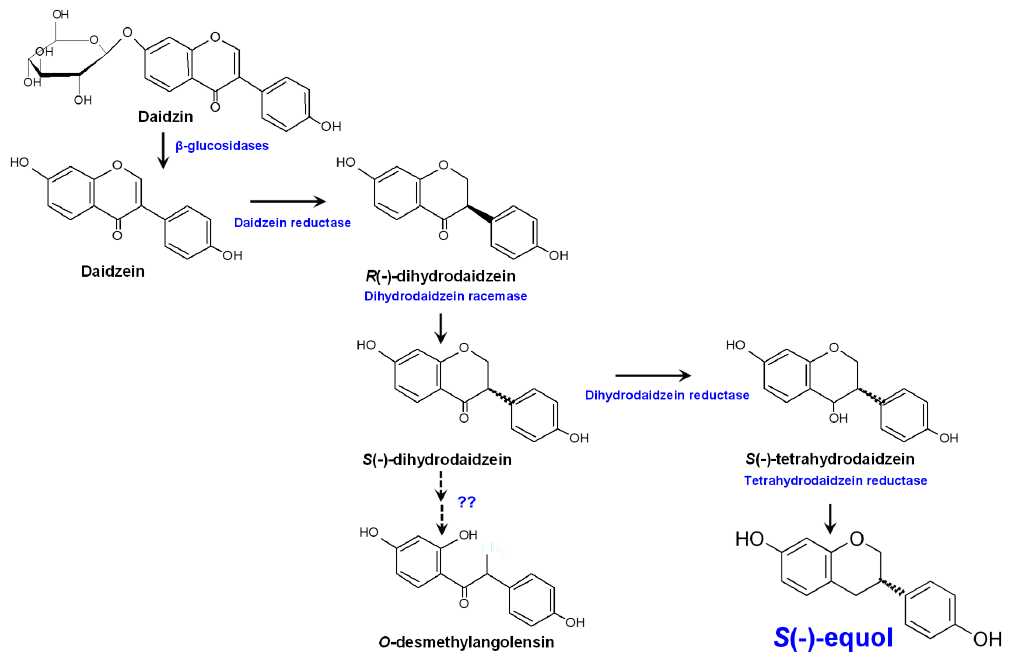
Figure 1. Metabolism of the isoflavone glucoside daidzein by the human gut microbiota and equol biosynthesis pathway